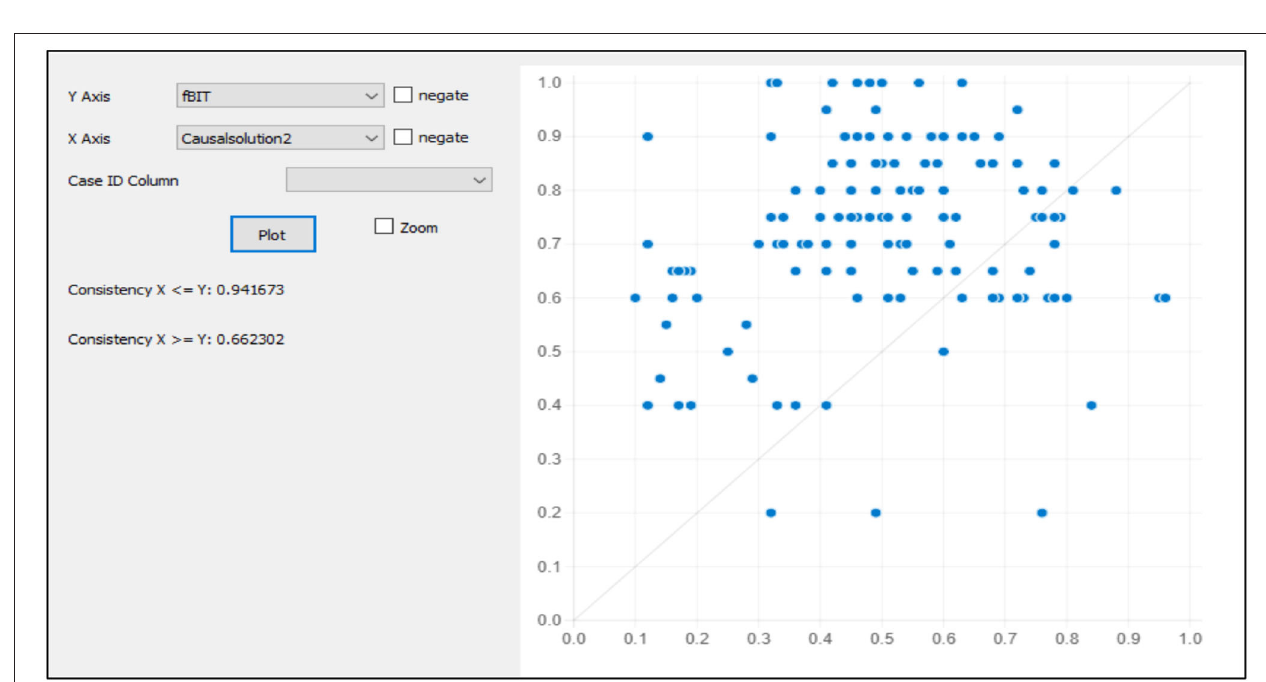
FIGURE 3 | Fuzzy plot for model 2 with holdout sample.